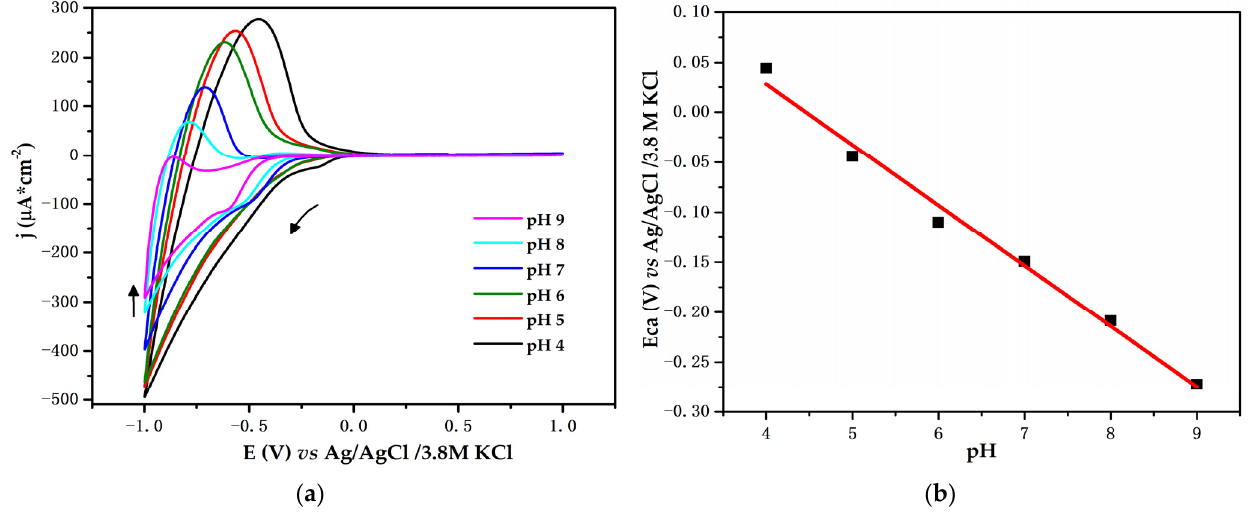
Figure 7. ( a ) Working electrode at varying pH values of PBS with glucose at 1 mM; v = 10 mV/s. Arrows depict the sense of potential sweep. ( b ) Relationship between cathodic potential vs. pH.